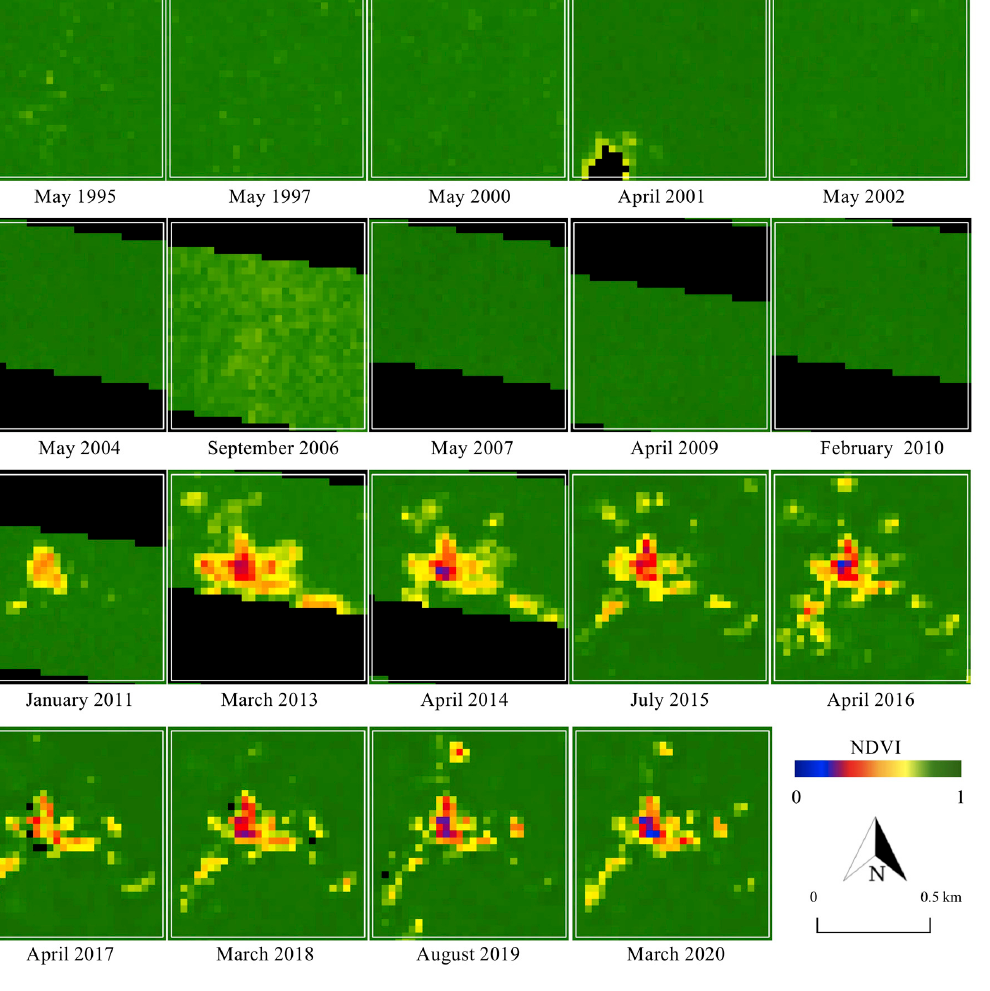
Figure 3. Changes in NDVI in Motomboto ASGM camp